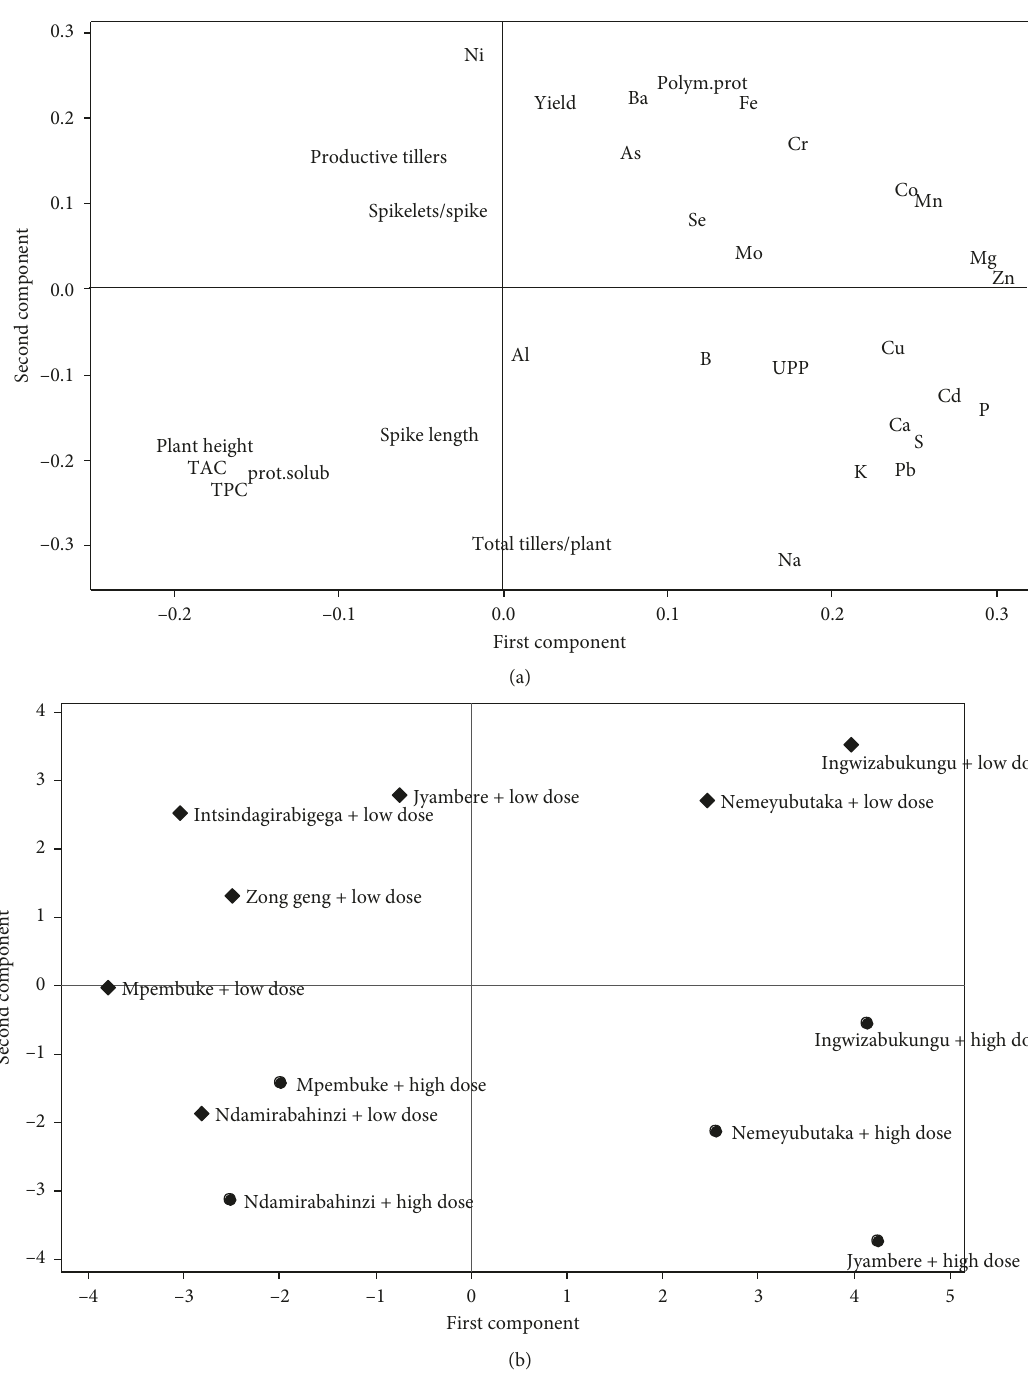
Figure 2: Loading (a) and score (b) plot from principal components analysis of grain yield, its components, mineral elements, total phenolic content, total antioxidant capacity, polymeric protein, protein solubility, and UPP. First principal component explained 32% of the variation while the second principal component explained 19.9% of the